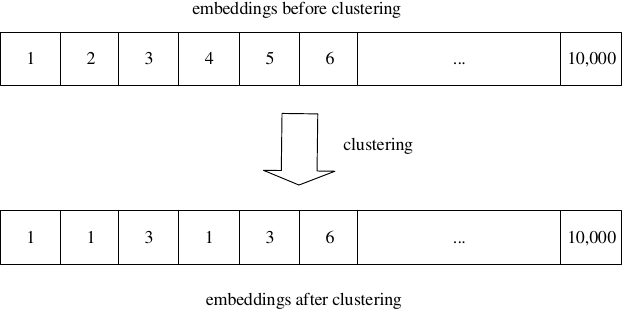
Figure 3. The process of clustering